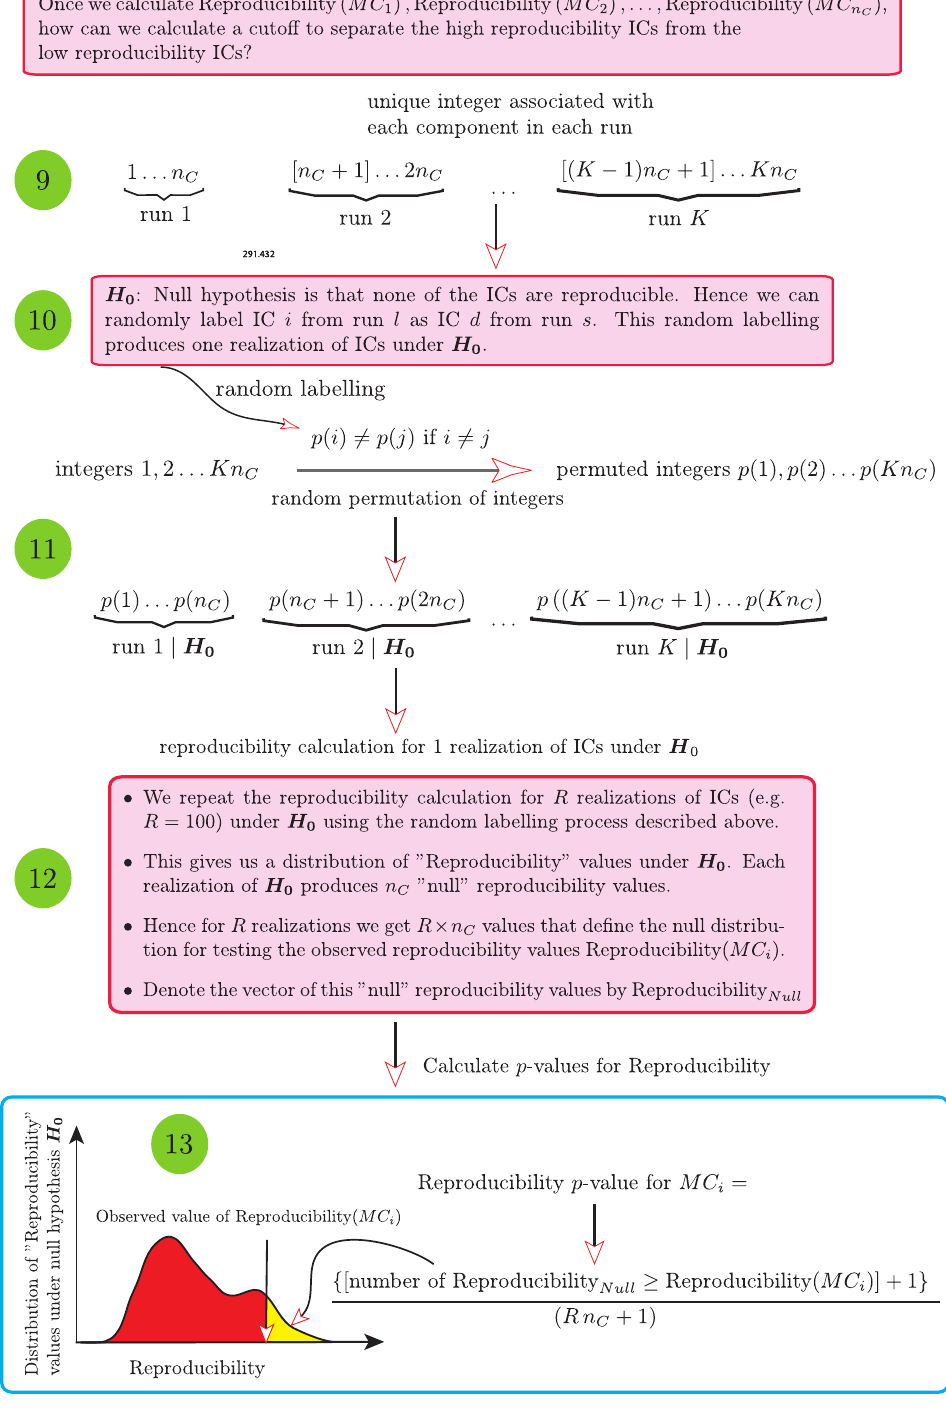
Figure 3. Pictorial depiction of the process for generating a ‘‘null’’ distribution in RAICAR-N. Our ‘‘null’’ hypothesis is: ‘‘ H 0 : None of the ICs are reproducible. Hence, we can randomly label IC i from run l as IC d from run s ’’. Therefore we randomly split the Kn C ICs across K runs into K parts and run the RAICAR algorithm on each set of randomly split ICs. This gives us a set of ‘‘null’’ reproducibility values which can be used to compute p -values for the observed reproducibility of ICs in the original RAICAR run. The green circles indicate the sequence of steps for generating the ‘‘null’’ distribution after the steps in Figure 2.